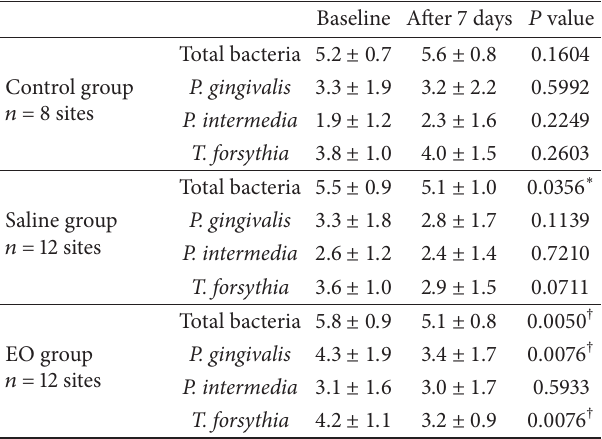
Table 3: Comparison of subgingival bacterial counts in shallow pockets (PPD = 4-5mm).